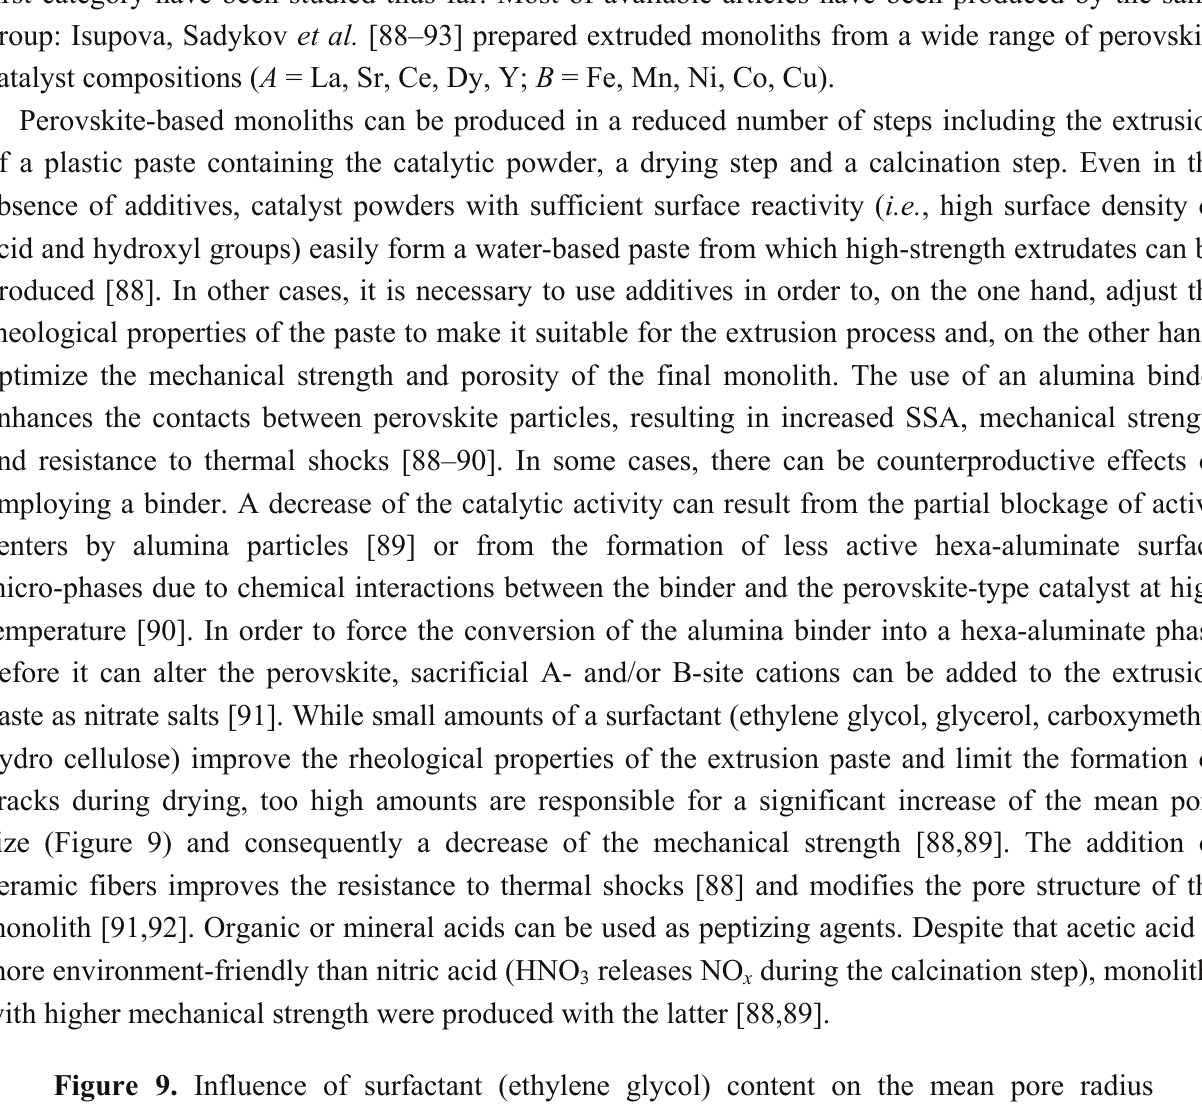
Figure 9. Influence of surfactant (ethylene glycol) content on the mean pore radius of monolithic LaMnO . Adapted with permission from Isupova et al. [88]. 3